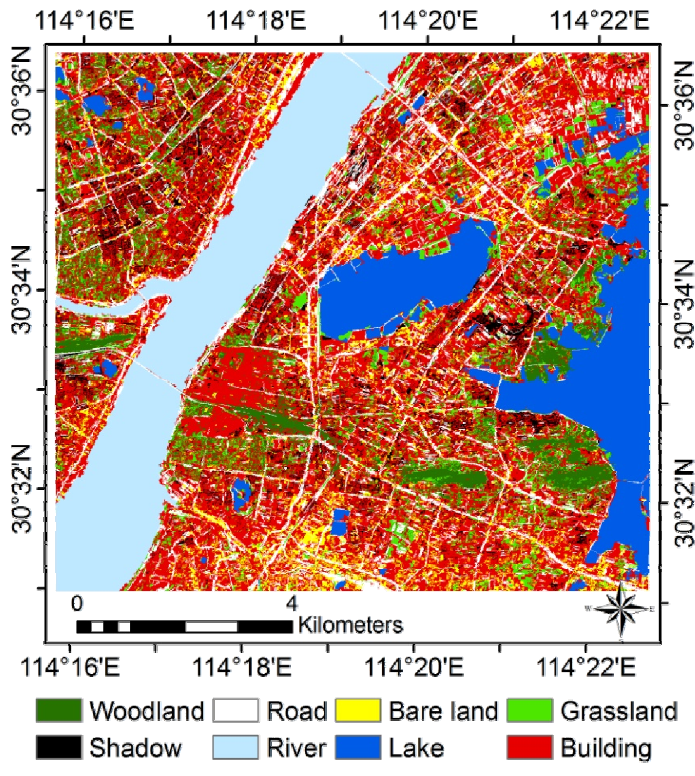
Figure 4. Land use/cover map derived from GE imagery.